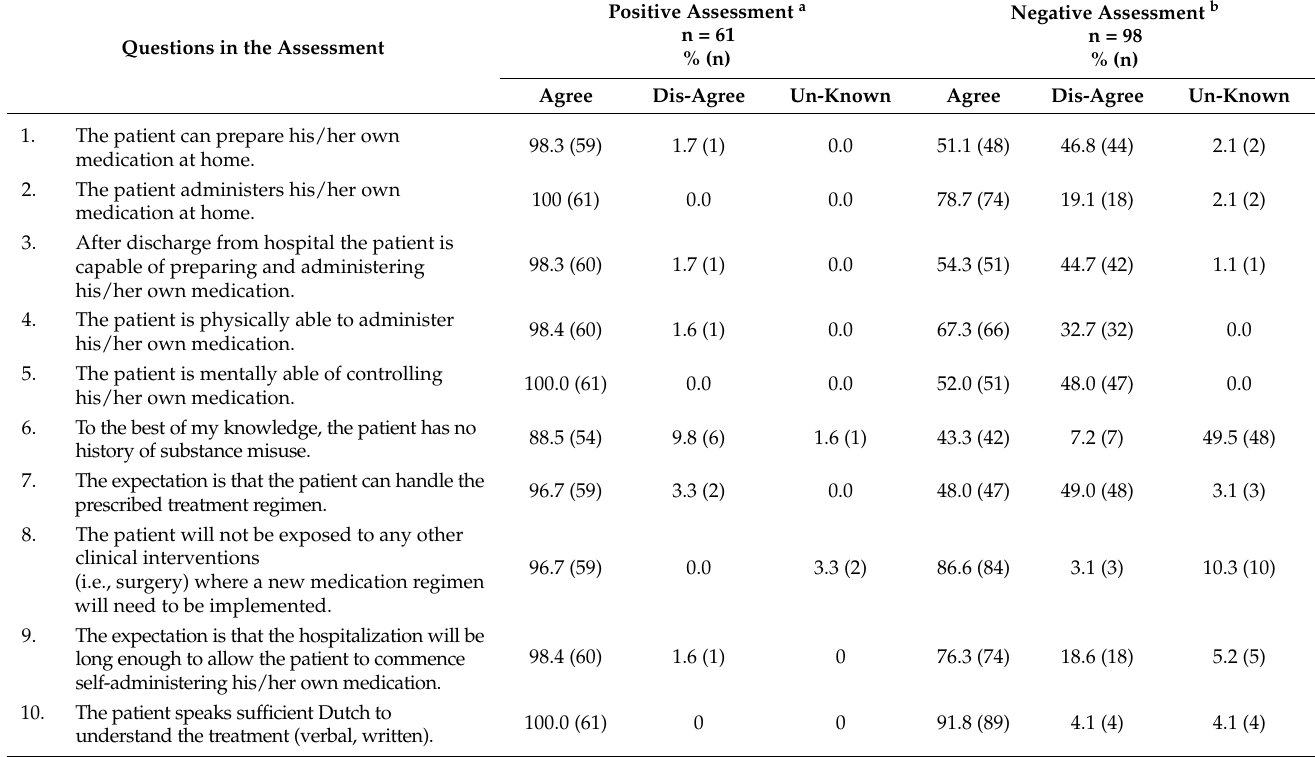
Table 1. Results of the nurse